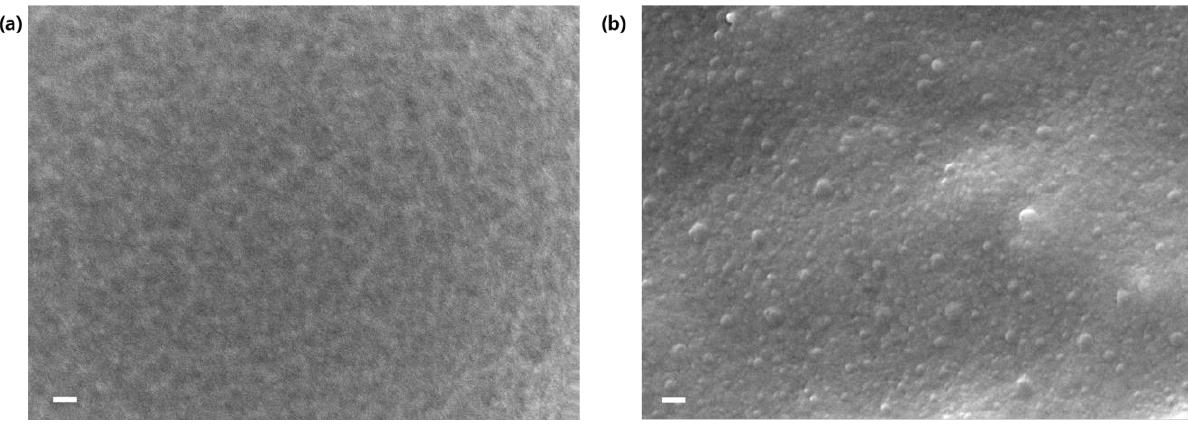
Figure 7. FESEM images of the fractured surface of ( a ) NC-3 and ( b ) NC-4 after a notched Izod impact test. A scale bar represents 100 nm.